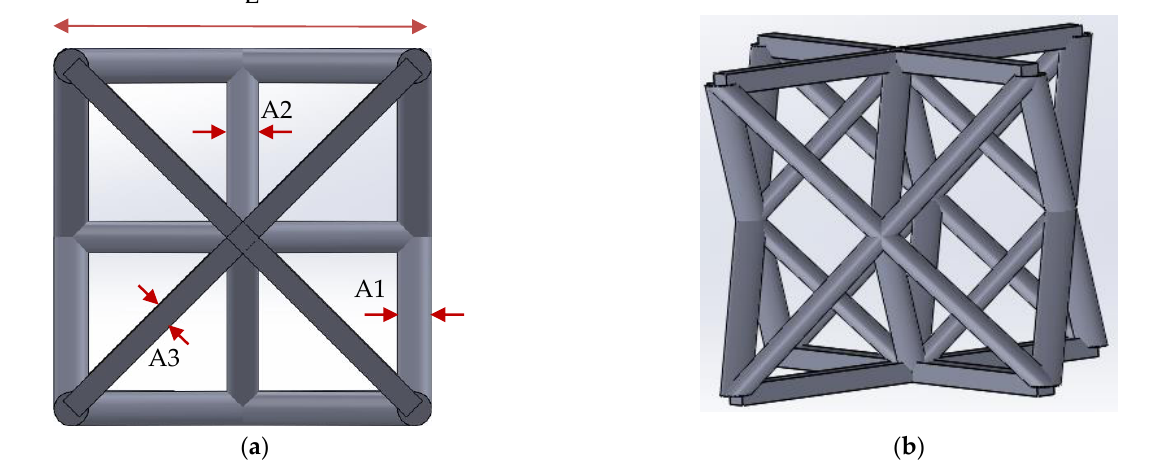
Figure 2. ( a ) Top view and ( b ) side view of the micro-lattice truss unit cell.